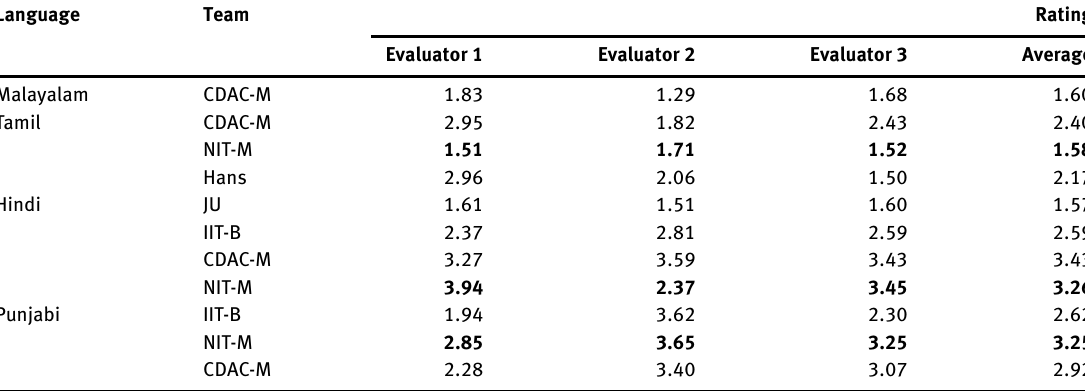
Table 4: Rating Table.